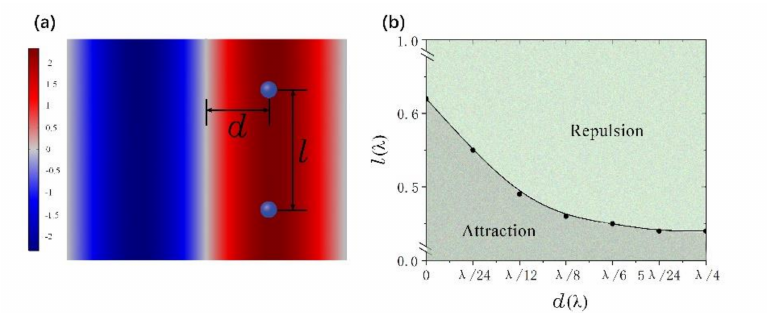
Figure 4. ( a ) A pair of particles located in a standing wave field with a distance d to the pressure node and separated from each other by a distance l . ( b ) Phase diagram of the secondary ARF acting on a pair of spheres in a one-dimensional standing wave. The dependence of the attraction-repulsion behavior on the position of the particle in the standing wave field in the two-particle